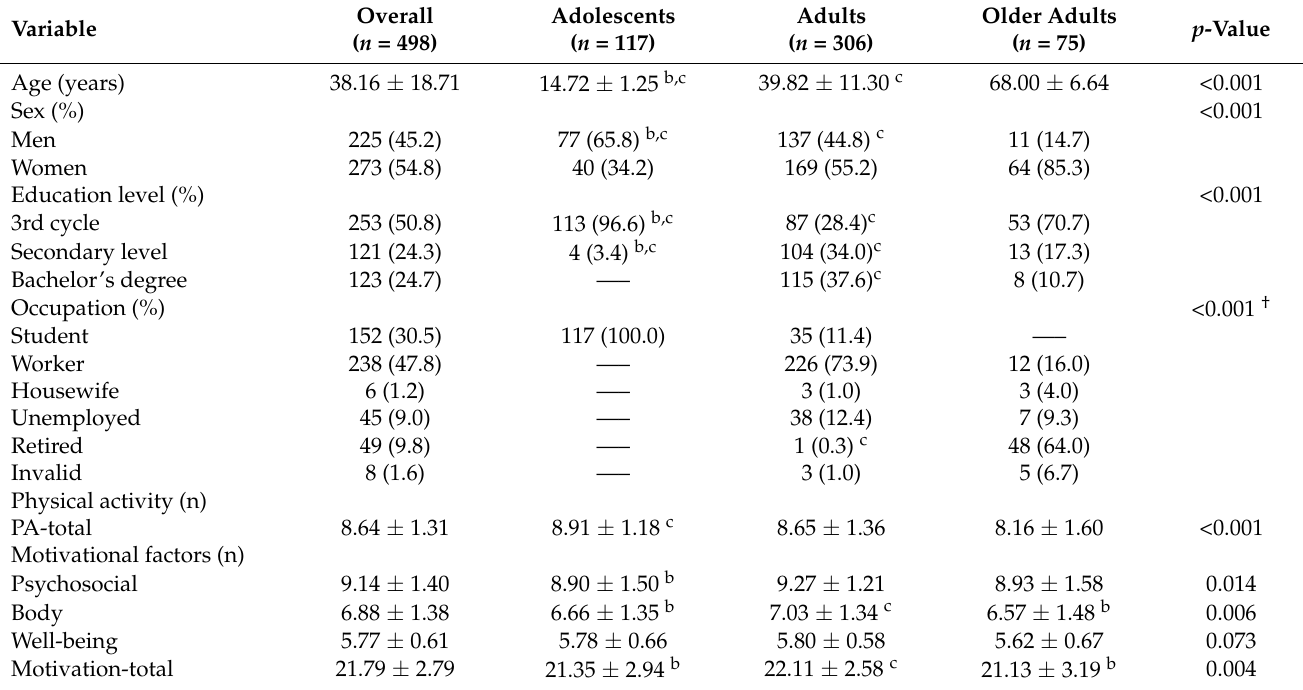
Table 1. Main characteristics of the